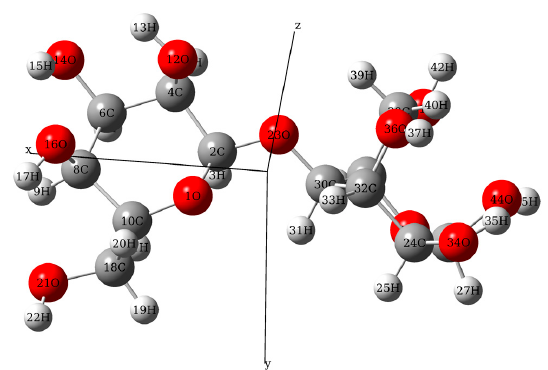
Figure 5. The molecular geometric configuration of the isolated cellobiose molecule.